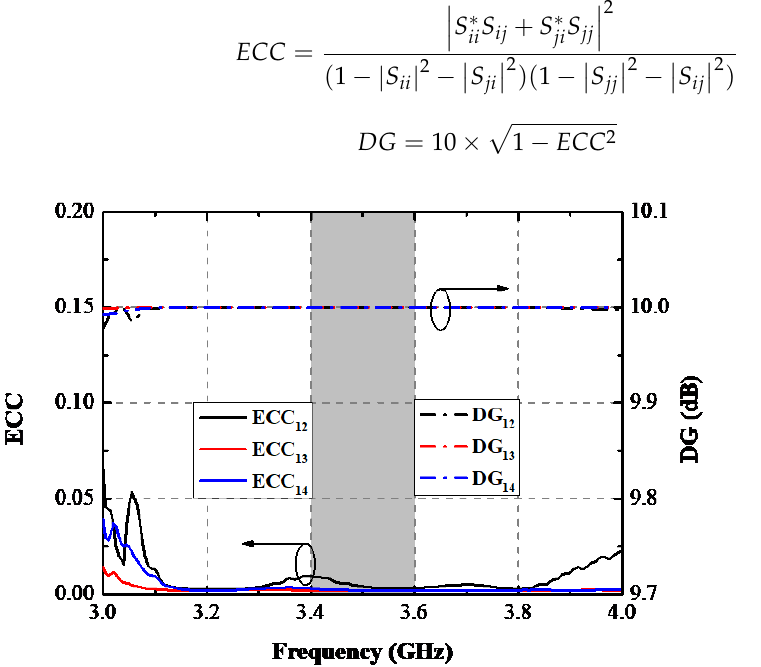
Figure 13. Measured and simulated gain and radiating efficiency of the proposed AP system. ECCs, DGs, TARCs, and MEs were computed to assess the diversity performance of the proposed design. As a vital parameter to evaluate the MIMO performance of the MIMO system, ECC was calculated by Equation (1) to obtain a precise observation of the independent level of two antenna elements [19]. As illustrated in Figure 14, the worst ECC between Ant. 1 and Ant. 2 (Ant. 3 and Ant. 4) within the operational band was 0.012, while ECC 13 and ECC 14 were lower than 0.009 and 0.007, respectively. Figure 14 also presents the calculated DGs by formula (2) [18], and a 10 dB DG was realized in the target operating band, explaining that the reported AP is qualified to be applied to smartphones.